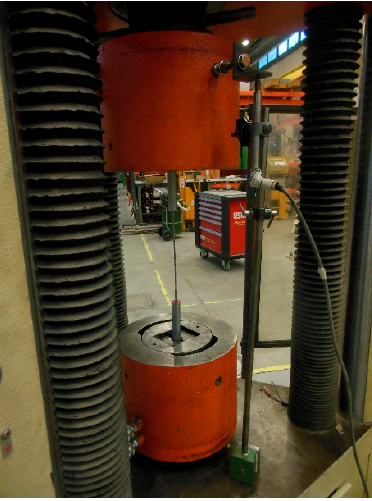
Figure 19. Positioning the LVDT (Linear Variable Differential Transformer) to measure the displacement of the crosshead.